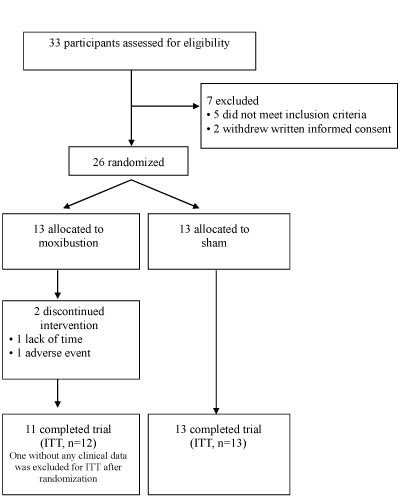
CONSORT flow chart.